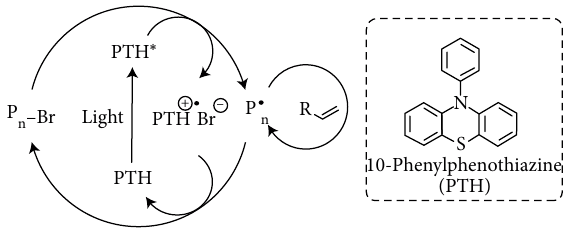
Figure 1: Proposed mechanism of metal-free photo-mediated ATRP with 10-phenylphenothiazine as the catalyst (Pn = polymer chain). (Adapted with permission from Ref.